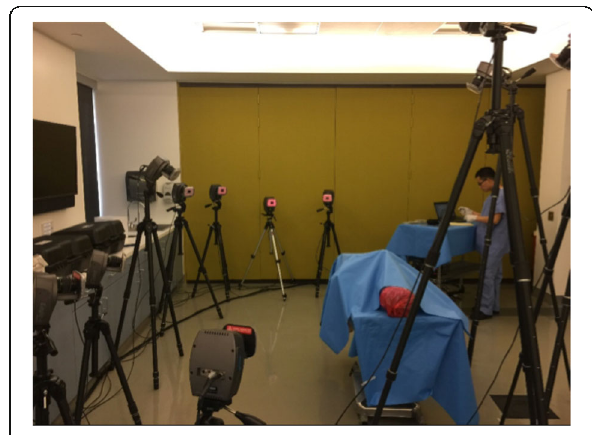
Fig. 2 Room set up for the measurements. An operating room (OR) table was positioned in the center of twelve motion analysis cameras on tripods at different heights and angles. These cameras were pre-calibrated prior to each measurement